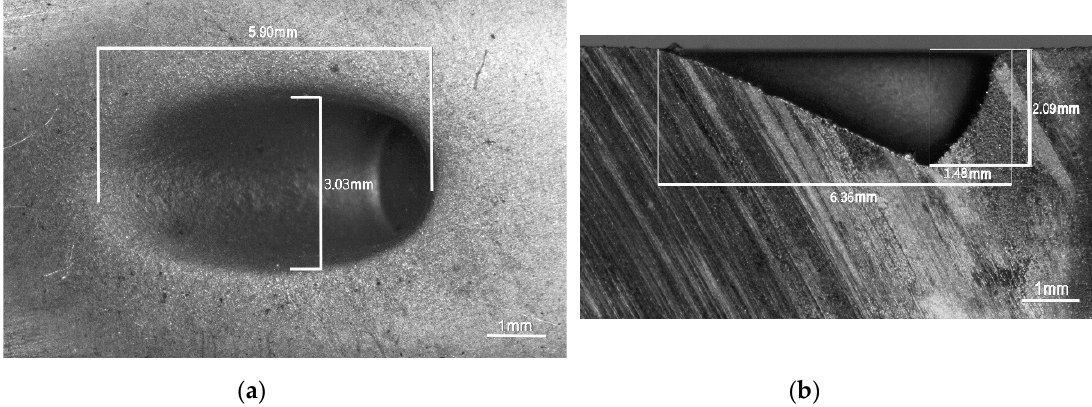
Figure 9. Geometry of the wear track. This track corresponds to one of the samples from Experiment 1 after 6 min of testing. ( a ) plan view; ( b ) side view.